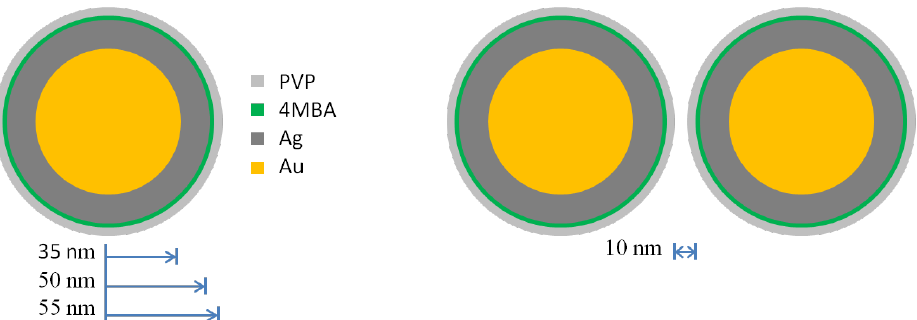
Figure 6. The multilayer sphere structure for modeling a single nanoparticle and a dimer structure: Au core with radius of 35 nm, Ag layer with thickness of 15 nm and PVP layer with thickness of 5 nm, the gap of air with distance of 10 nm.